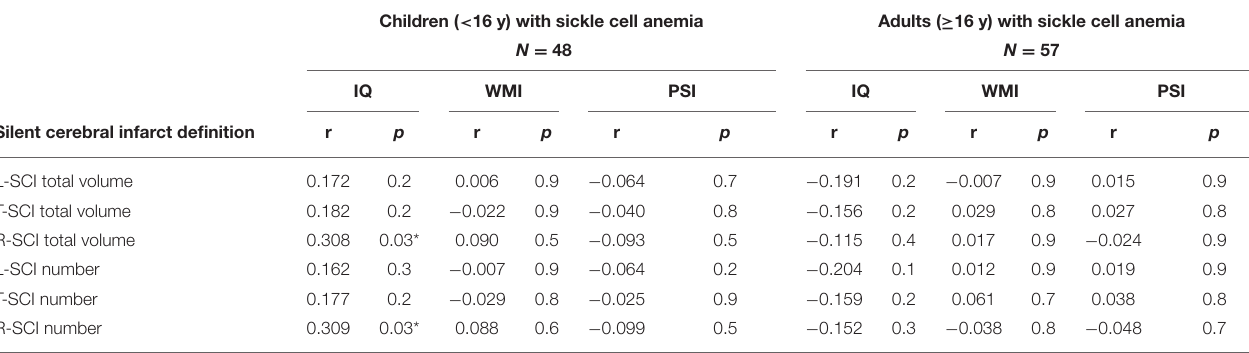
TABLE 4 | Spearman correlations for comparison of cognitive outcomes and silent cerebral infarct volume and number using the Liberal (L-SCI), Traditional (T-SCI) and Restrictive (R-SCI)